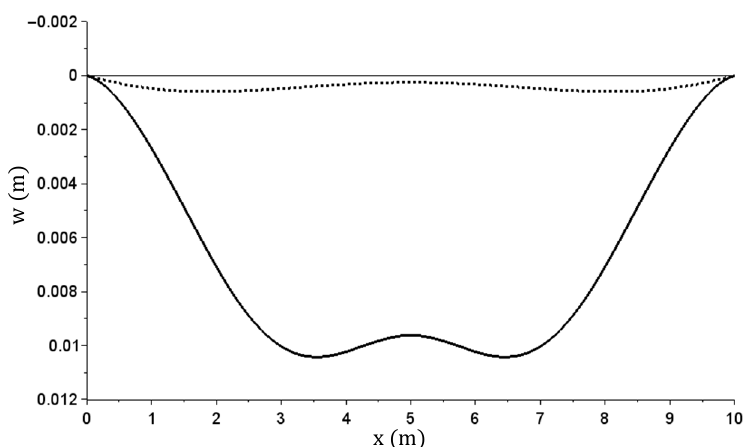
Figure 21. The w(x) [m] deflection graph—at maximum and after relief.